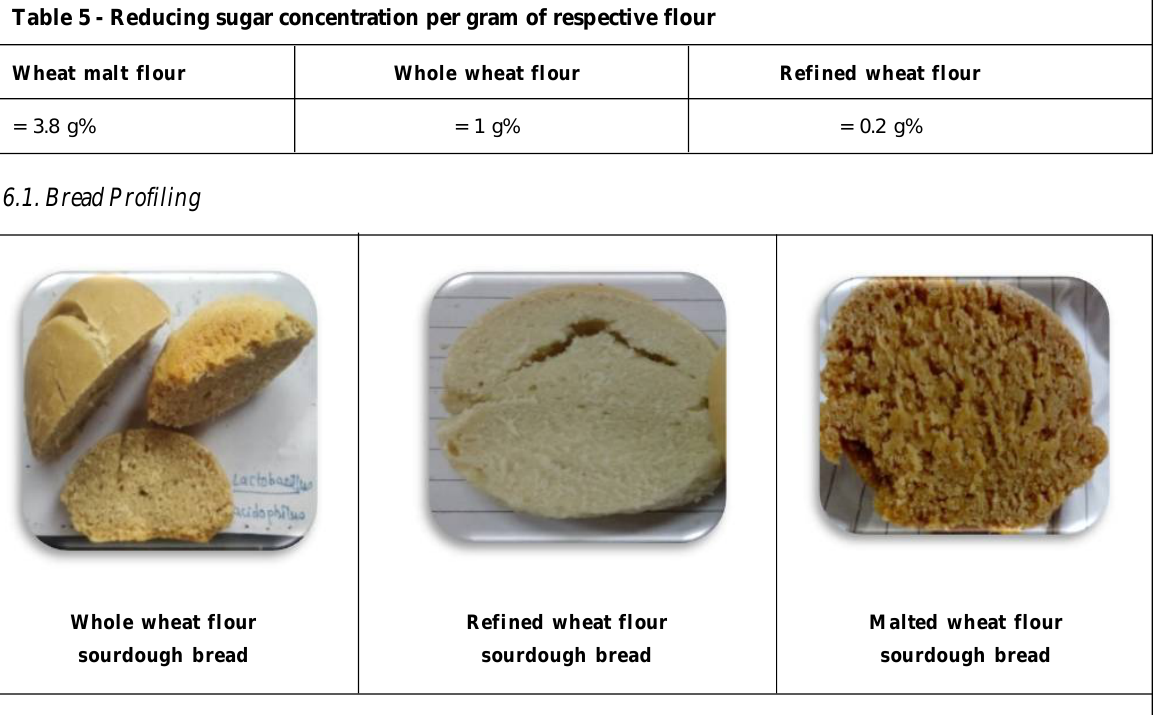
Figure 4: Breads fermented with L.acidophilus in three different flours